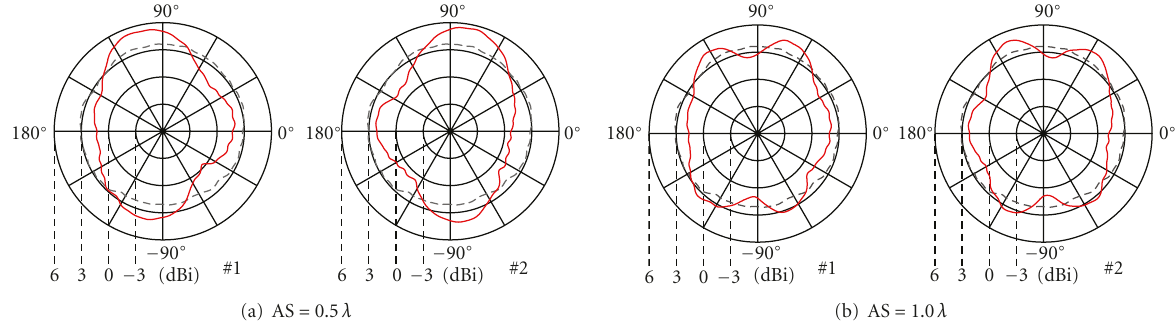
Figure 5: Antenna patterns for a two-element array with mutual coupling (solid curves) and single isolated antenna pattern (dashed curve).